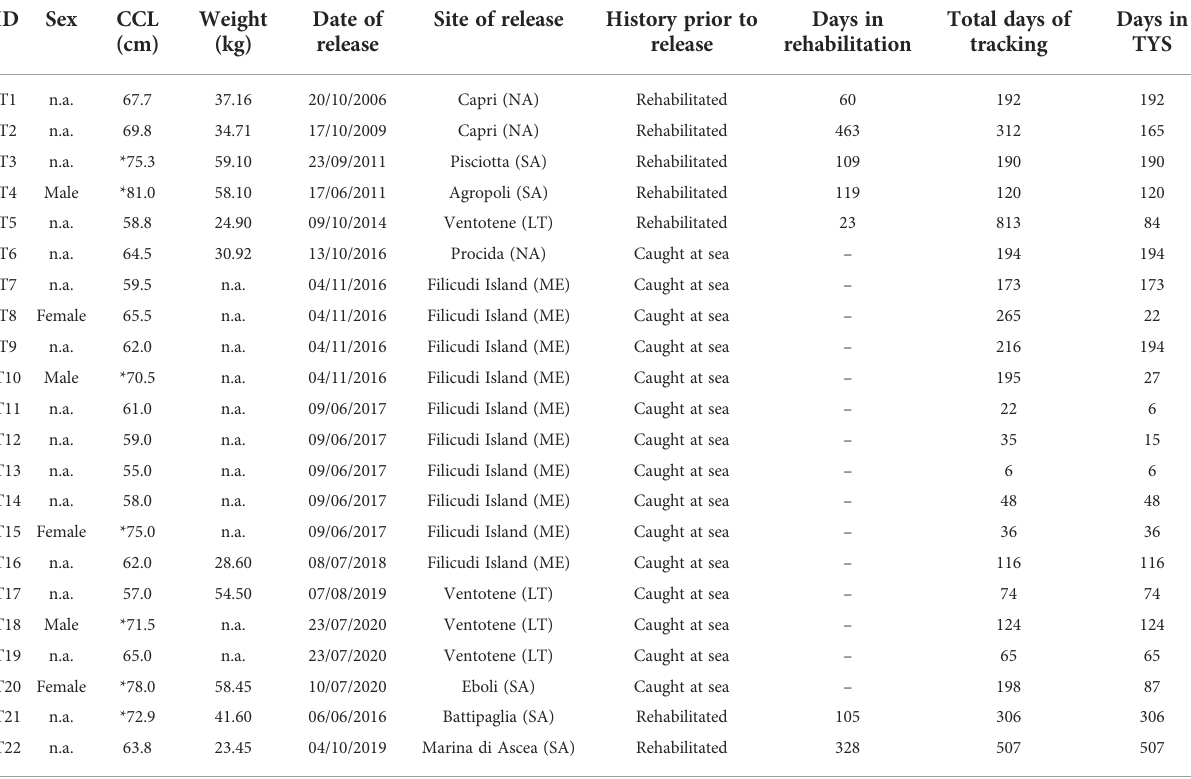
TABLE 1 Turtle ID, sex, curved carapace length (CCL) and weight, and total days of tracking and number of days tracked in the Tyrrhenian